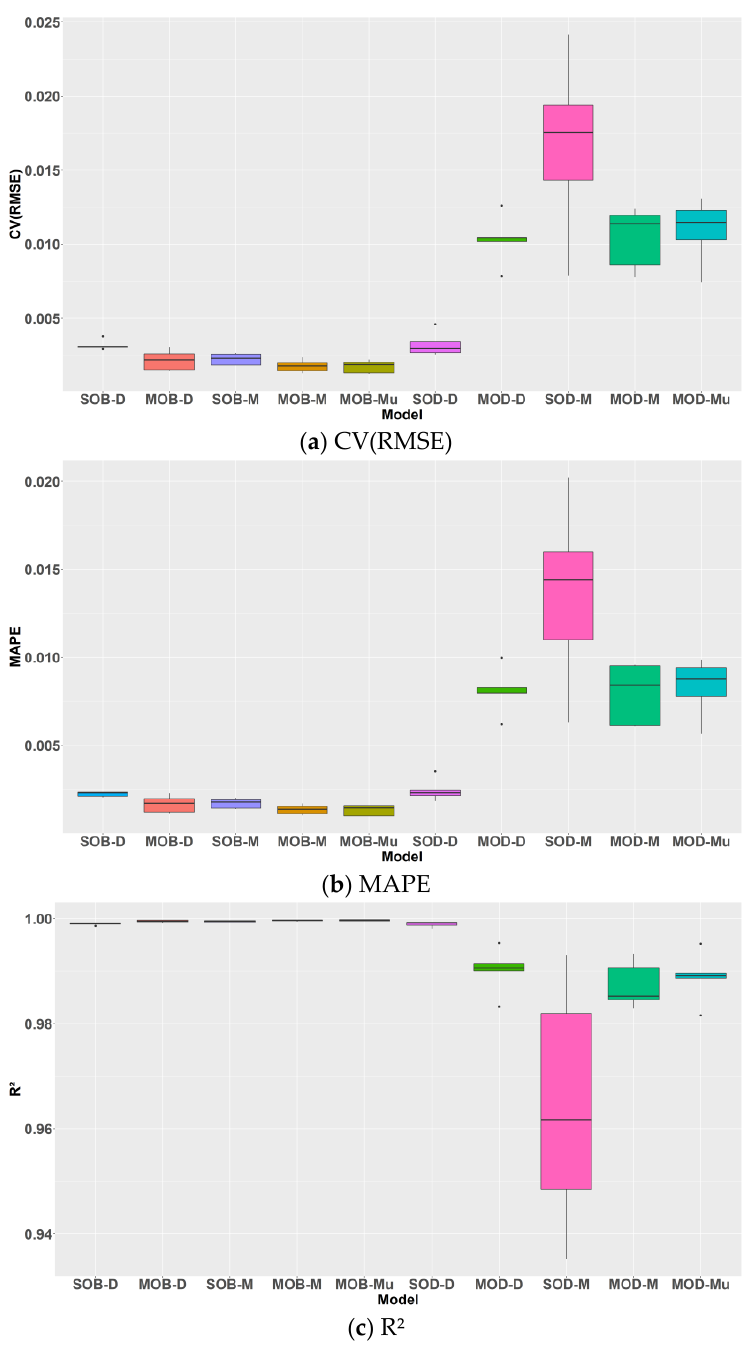
Figure 10. Performance of 10 models for monthly cooling energy (refer to Table 4 for model expla- nation).